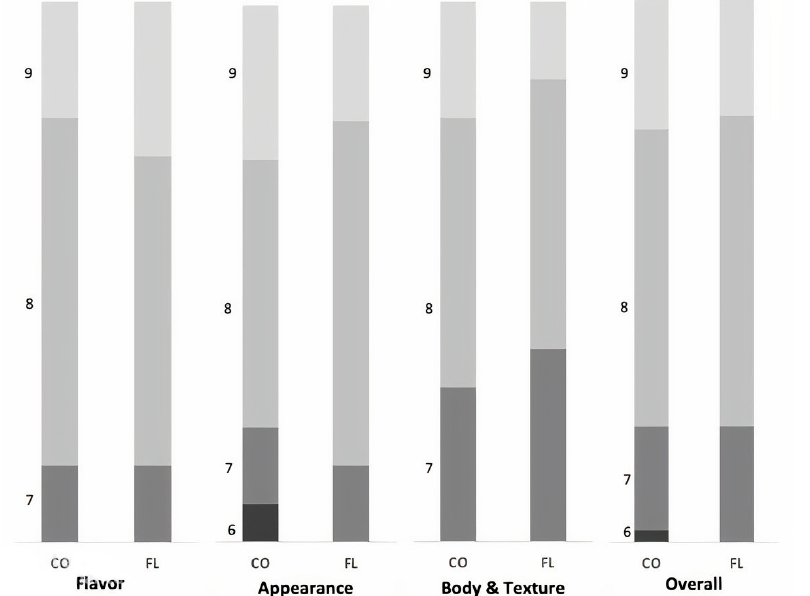
Figure 2. Effect of dietary addition of flaxseed and lupin on sensory panel scores of cheese samples Figure 2. E ff ect of dietary addition of fl axseed and lupin on sensory panel scores of cheese samples on fl avor, appearance, body, and texture and overall. N° replicates: 24 (12 samples per treatment) on flavor, appearance, body, and texture and overall. N ◦ replicates: 24 (12 samples per treatment) scored by 14 panelists. Results range: 1–3 low acceptance, 4–6 su ffi cient acceptance, and 7–9 very scored by 14 panelists. Results range: 1–3 low acceptance, 4–6 sufficient acceptance, and 7–9 very high acceptance. high Table 7. E ff ects of dietary supplementation of fl axseed and lupin seed on antioxidant status of milk and white cheese.